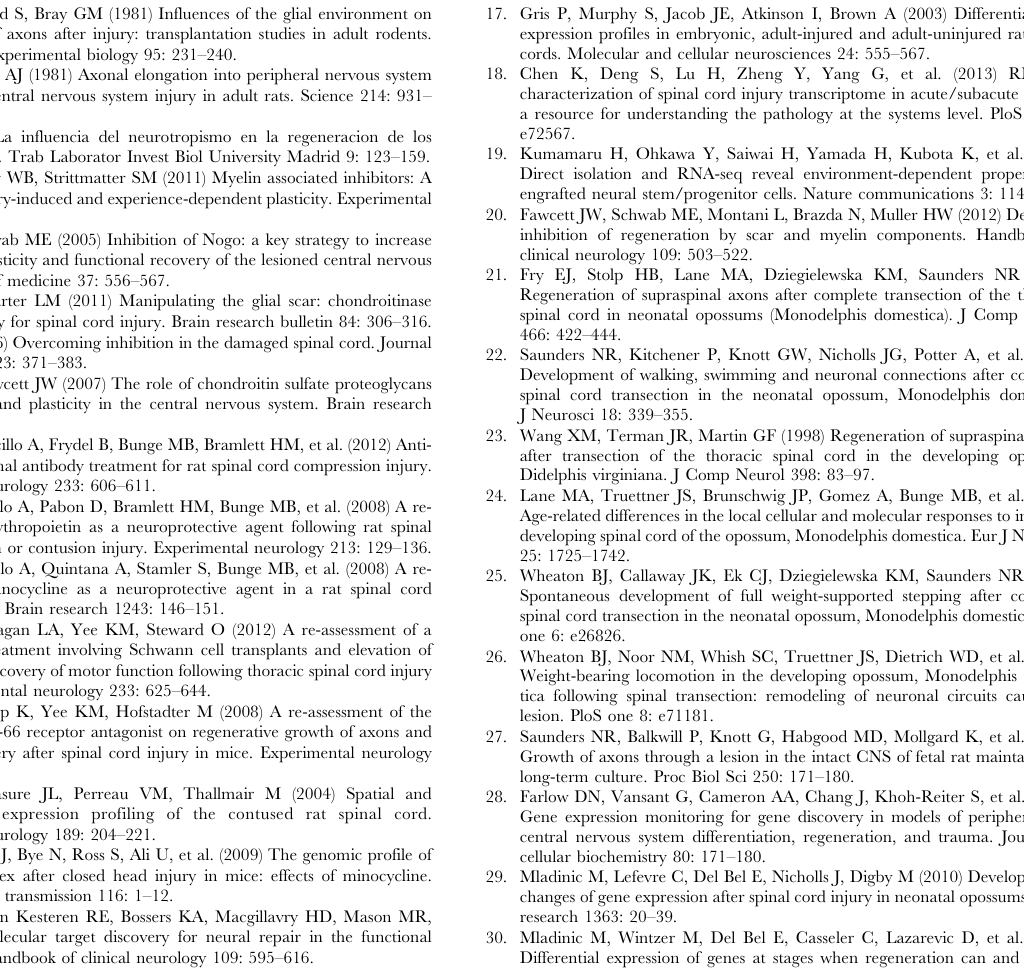
spinal cord. Proteins that were identified in the spinal cord rostral but not caudal to the site of transection 24 h after injury at P28. increased band density, decreased band density. Some proteins showed an increase or decrease in different fractions ( ). D : Monodelphis spinal cord. Proteins that were identified in the spinal cord caudal but not rostral to the site of transection 24 h after injury at P28. decreased band density. Some proteins showed an increase or decrease in different fractions ( ).